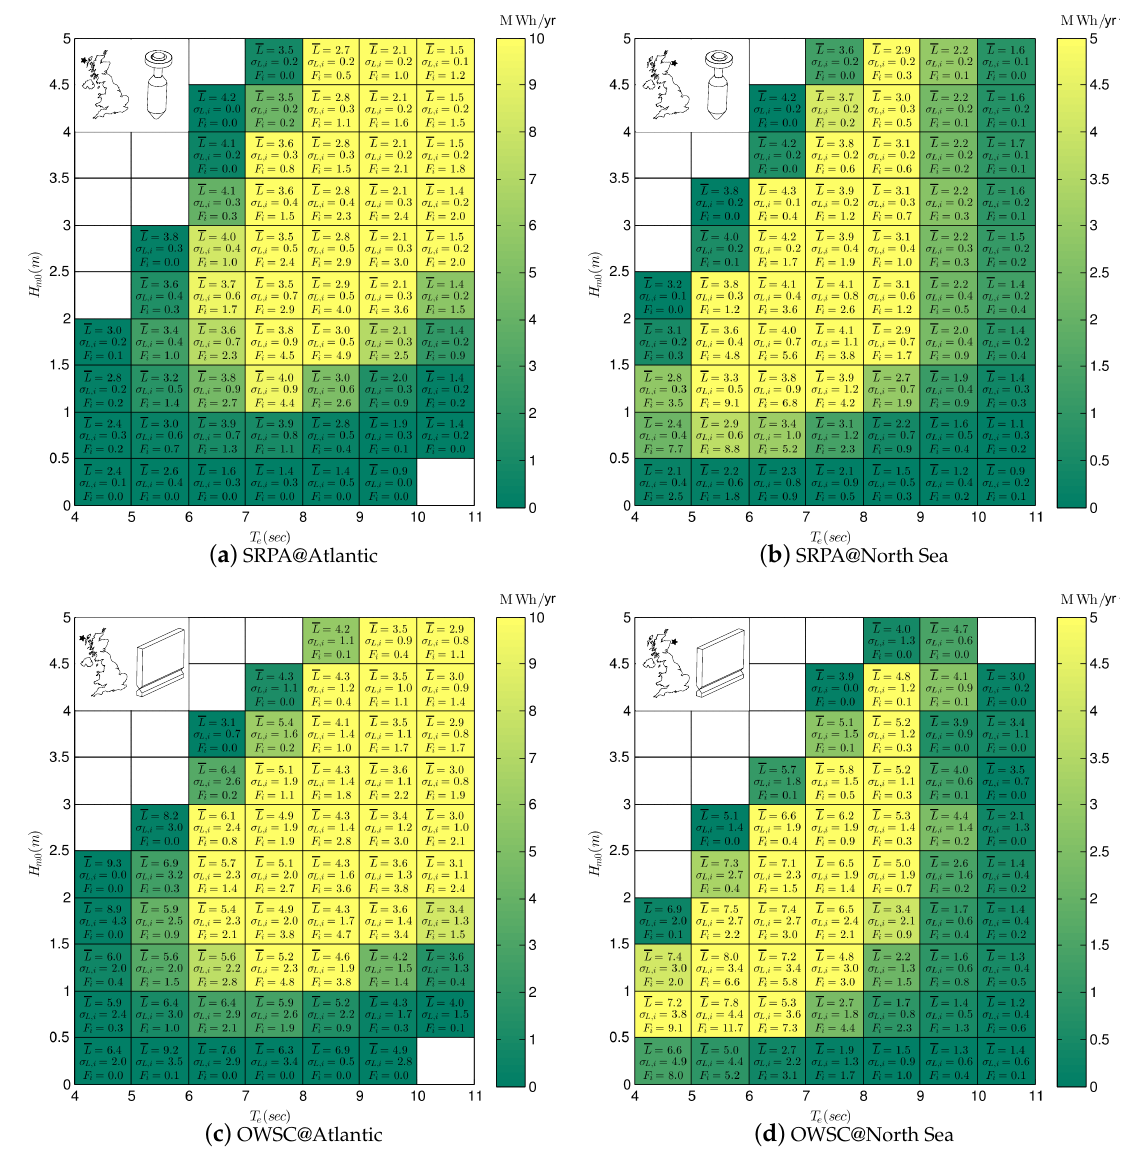
Figure 6. WEC performance matrices. Text indicates mean and standard deviation of capture length ( L i , σ L , i , in m) and frequency of occurrence ( F i as a percentage). Colour indicates average annual energy absorption in